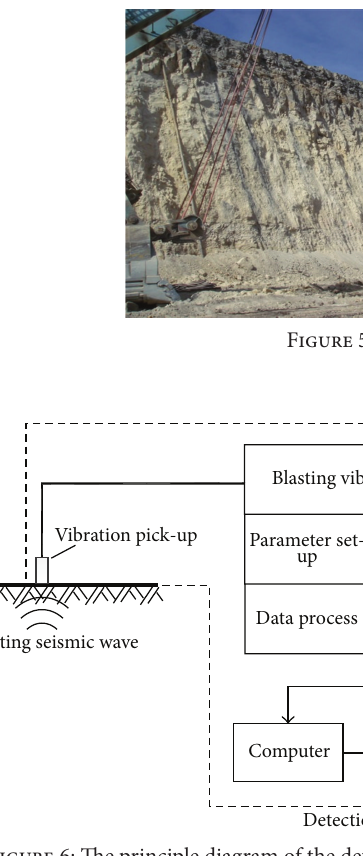
Figure 6: The principle diagram of the detection system.